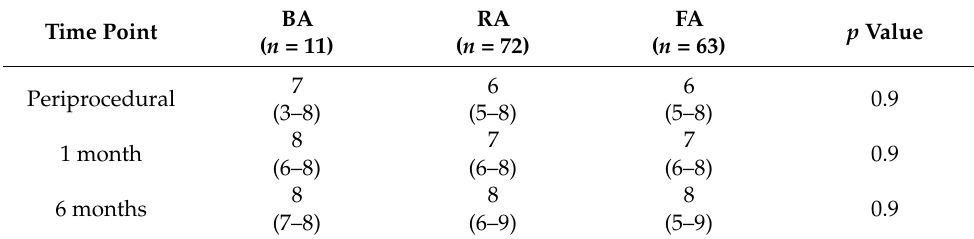
Table 6. EQ-VAS (Visual Analogue Scale)